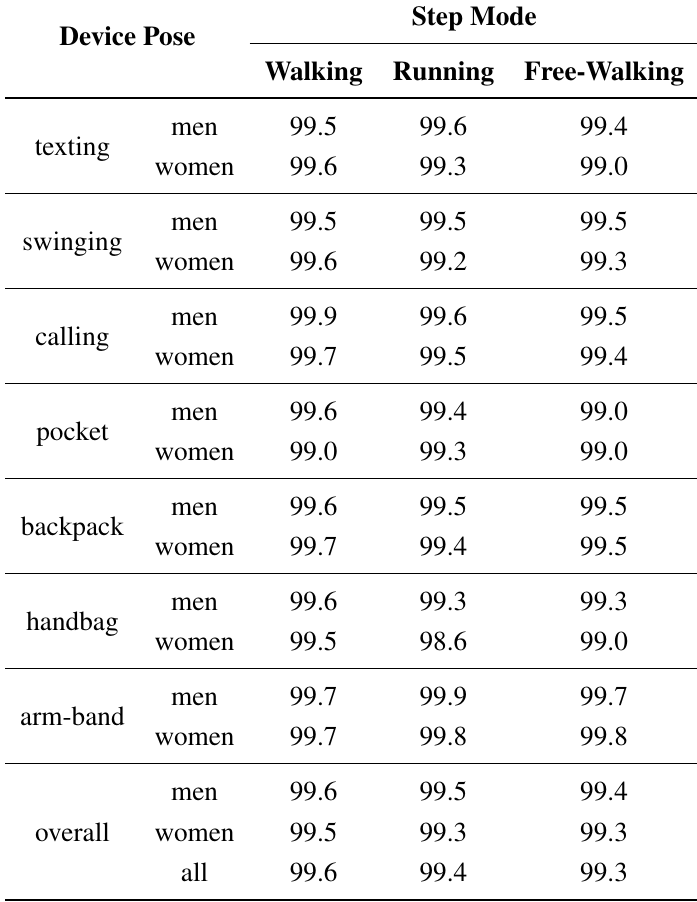
Table 3. Average accuracy of the proposed step detection